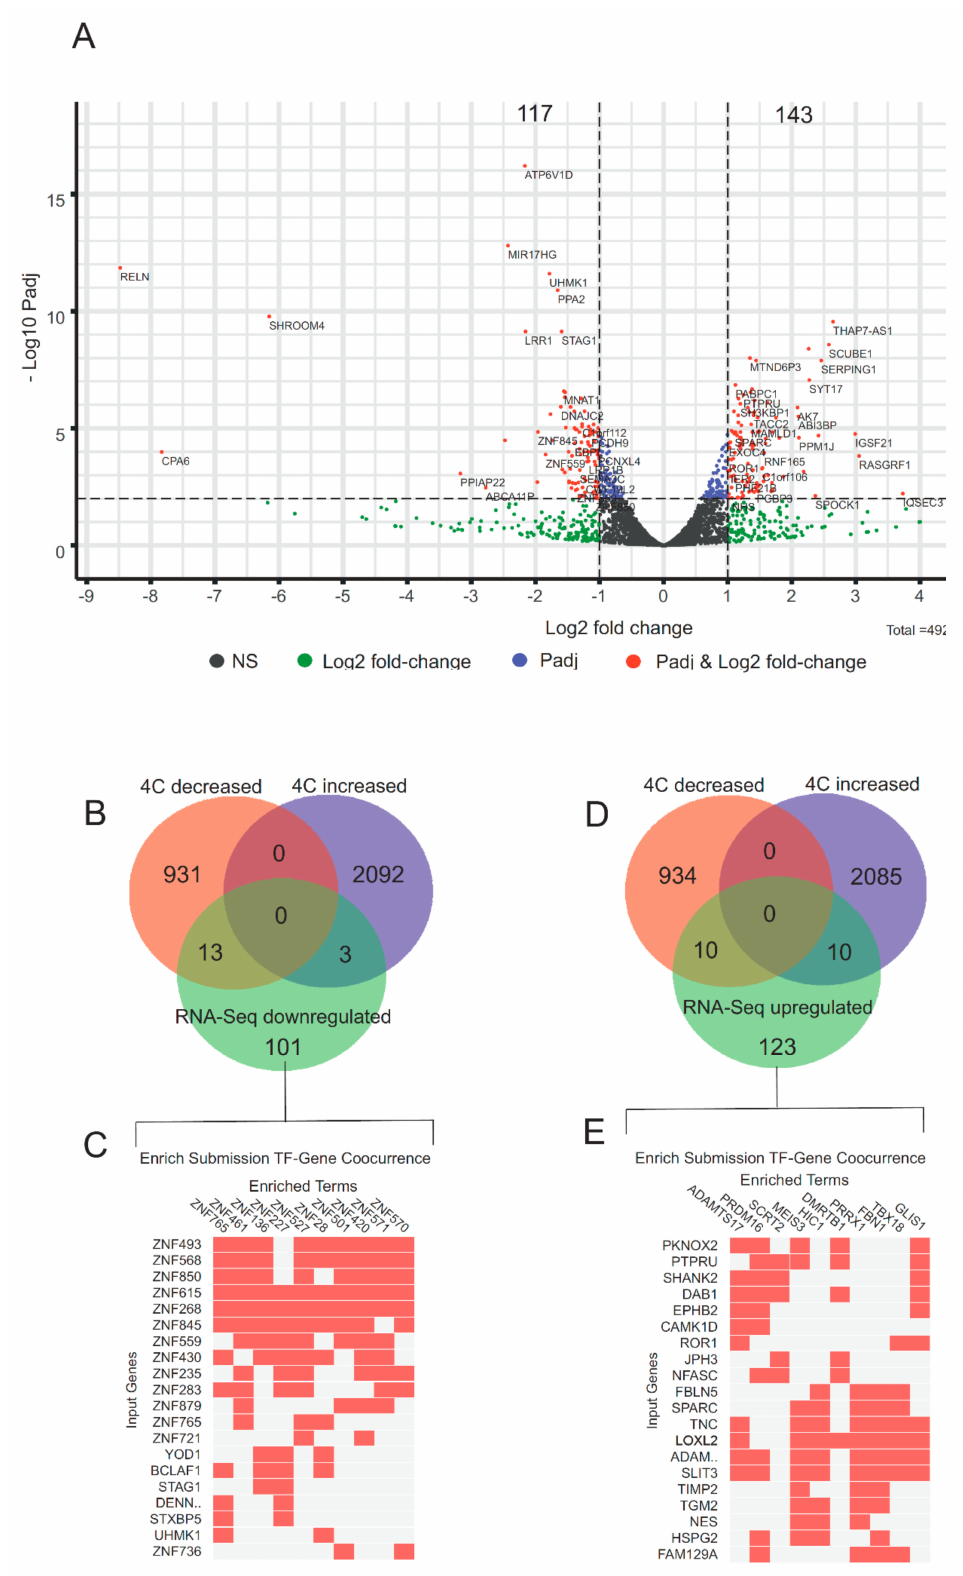
Figure 5. Di ff erential expression of rDNA-contacting genes after heat shock treatment. ( A ) The volcano plot presents the statistically significant log2-fold changes in the expression of rDNA-contacting genes determined in RNA-Seq experiments (after heat shock treatment and recovery at 37 ◦ C for 6 h). The expression of 4920 rDNA-contacting genes was analyzed. Of these, 177 genes were